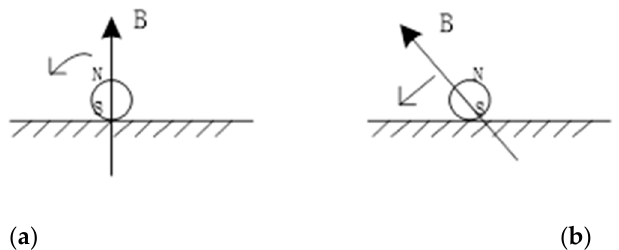
Figure 4. Hysteresis moments of magnetic particles on the surface of the separator. ( a ) Polarity of magnetic particles before magnetic field rotation, ( b ) Polarity of magnetic particles after rotation of magnetic field.